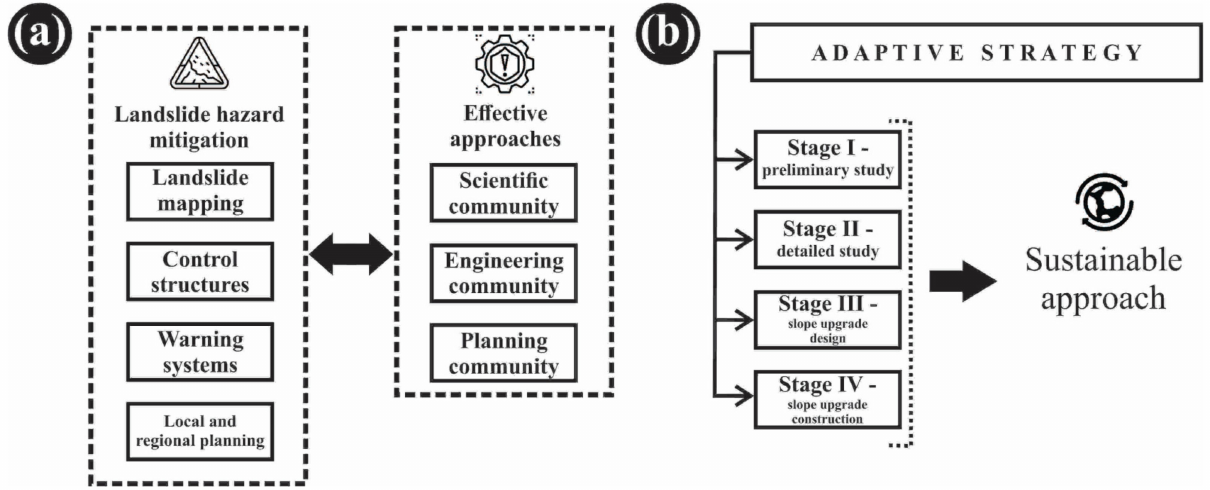
Figure 11. The landslide hazard mitigation approach ( a ) and sustainable adaptive strategies ( b ). Data source: modified after